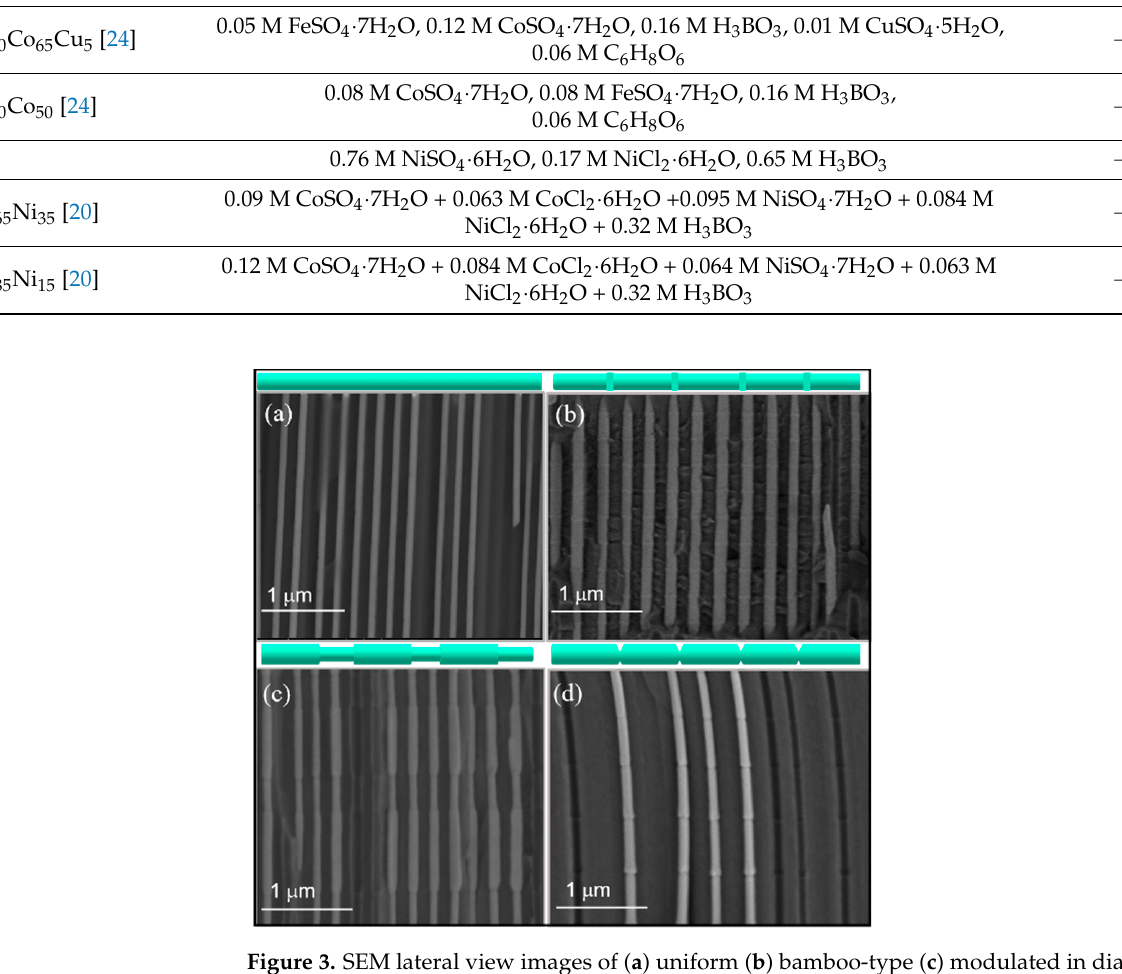
Table 1. Materials and parameters used in electrodeposition. Material